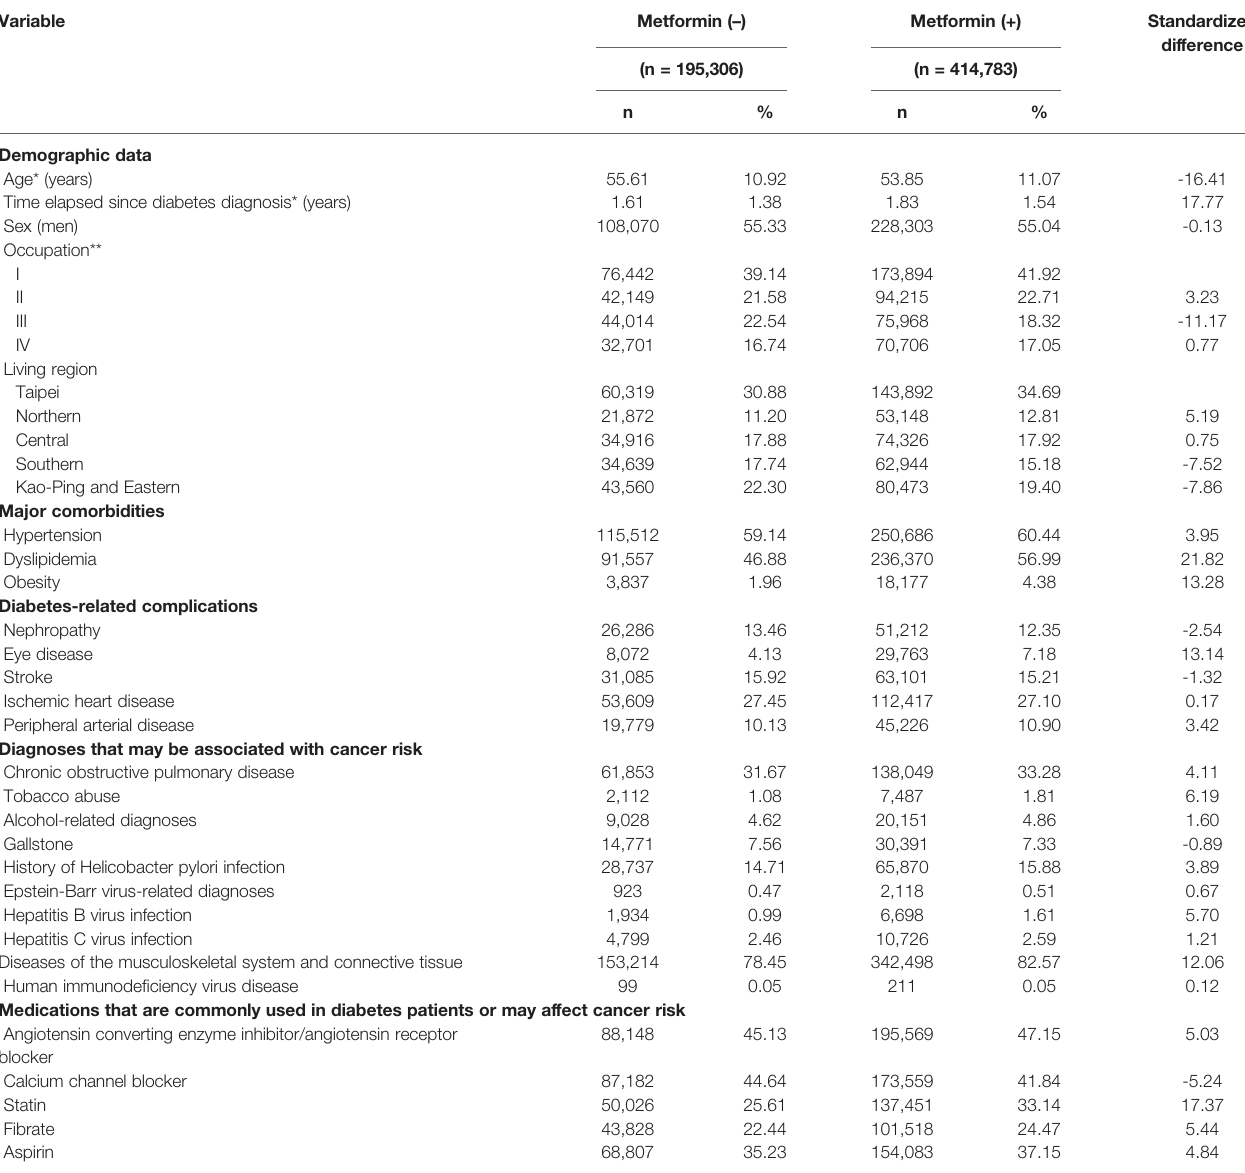
TABLE 1 | Baseline characteristics in non-metformin initiators and metformin initiators. Variable Metformin ( – ) Metformin